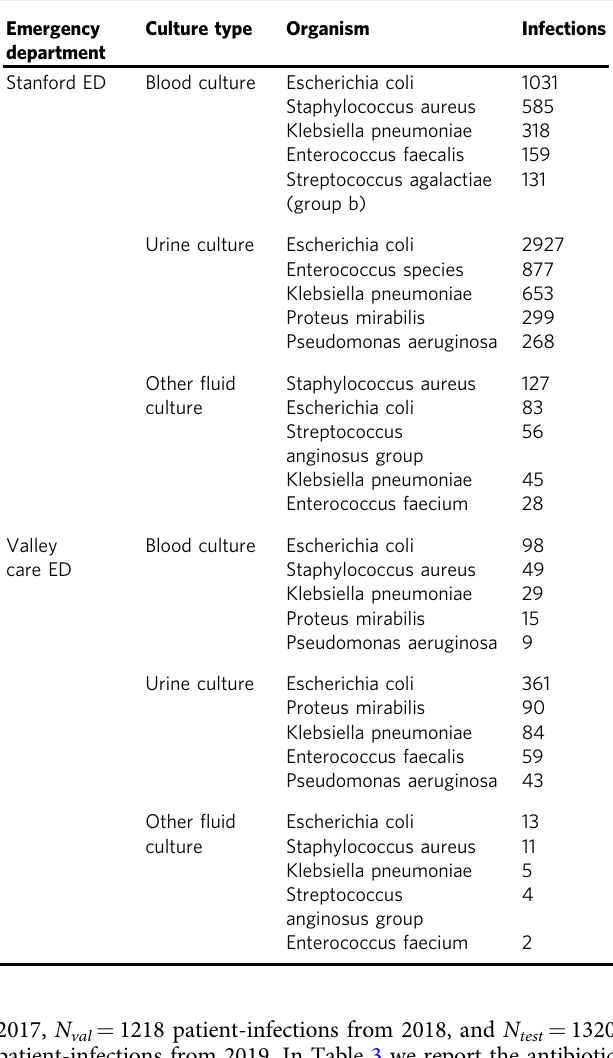
Table 2 Most frequently isolated species grouped by microbial culture type and emergency